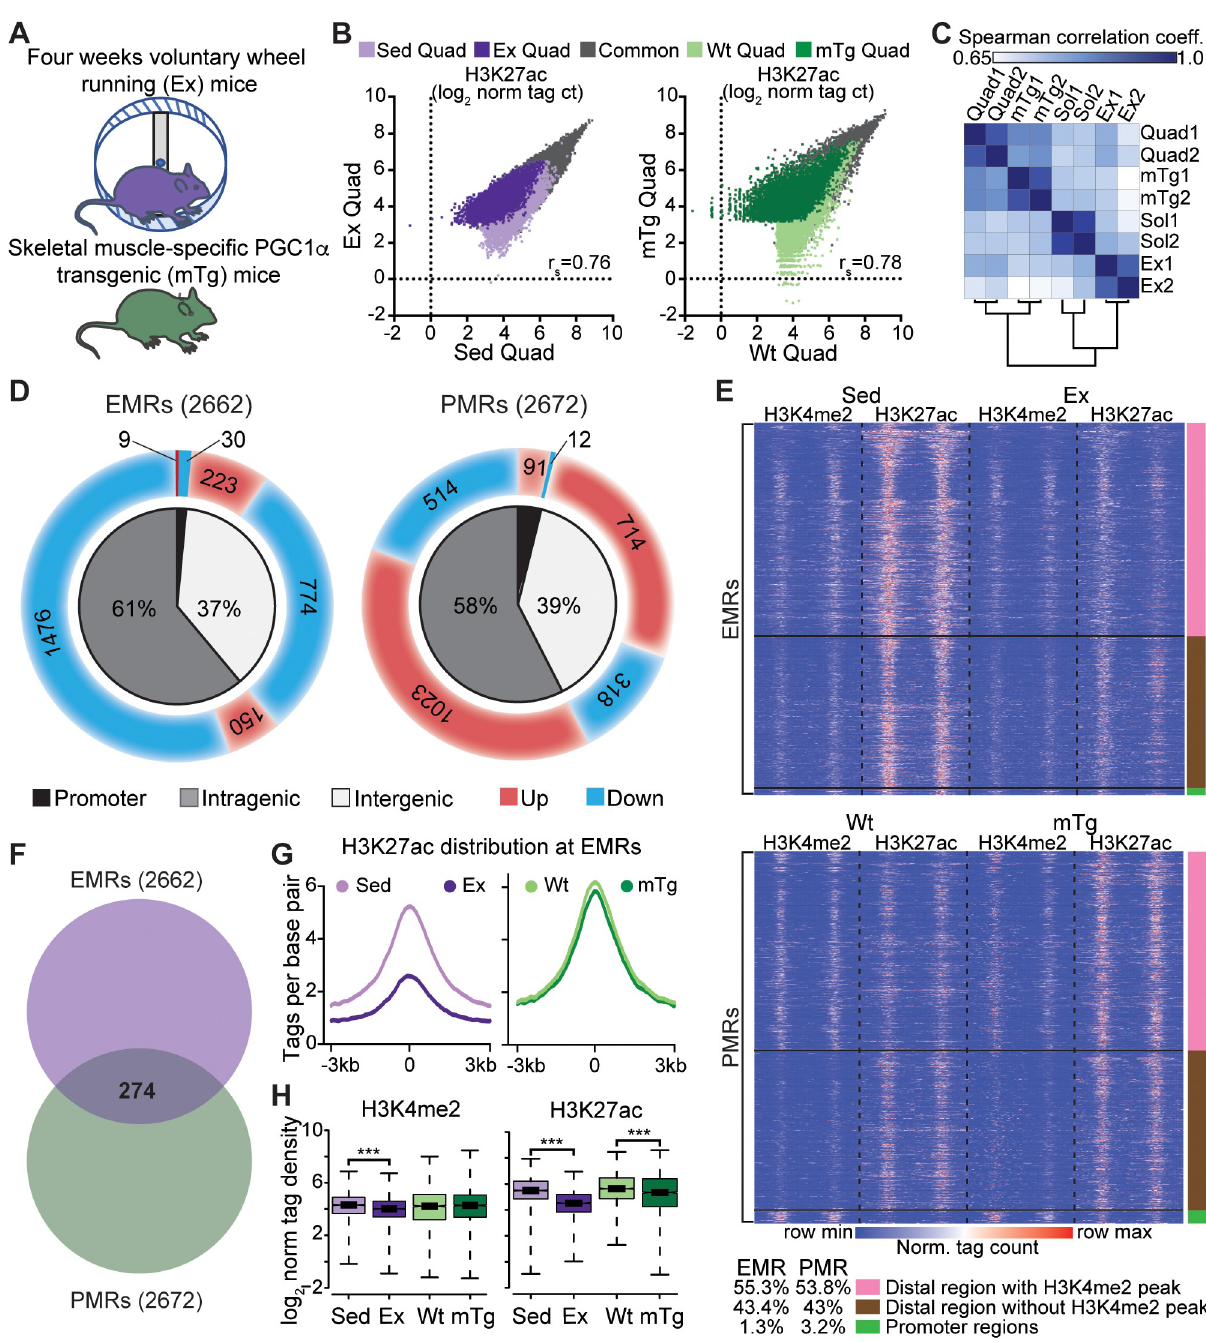
Fig 6. Exercise and PGC1 α modify the epigenome at different regions. (A) Experimental scheme of voluntary wheel running (Ex) and skeletal muscle–specific Pgc1a overexpression (mTg). Ex mice were placed in cages with wheels for 4 weeks. (B) Scatterplots of normalized H3K27ac tag counts at regions marked by H3K27ac in Sed versus Ex Quad (left) and Wt versus mTg Quad (right). Correlation coefficient (r s ) was calculated for each scatterplot; n = 2/group. (C) Similarity matrix with Spearman correlations for H3K27ac profiles in Quad and Sol, Ex and mTg Quad with correlation coefficient (r s ) in color. (D) Pie charts with locations and H3K27ac signal changes at EMRs and mTg-modified regions (PMRs). Inner charts show peak distributions in promoter, intragenic, and intergenic regions. Outer charts indicate the direction of the acetylation change, with red for hyperacetylation and blue for hypoacetylation. (E) Heatmap distribution of H3K4me2 and H3K27ac tags within 6 kb of EMR (top) and PMR (bottom) peaks in Sed versus Ex Quads and Wt versus mTg Quads, respectively; n = 2/group. Color bars on the right correspond to promoter regions, promoter-distal regions with H3K4me2 peaks, or promoter-distal regions without H3K4me2 peaks. (F) Venn diagram with overlap between EMRs and PMRs. (G) Histograms showing distribution of H3K27ac tags within 6 kb of EMR peak centers in Ex and mTg mice and controls; n = 2/group. (H) Quantification of